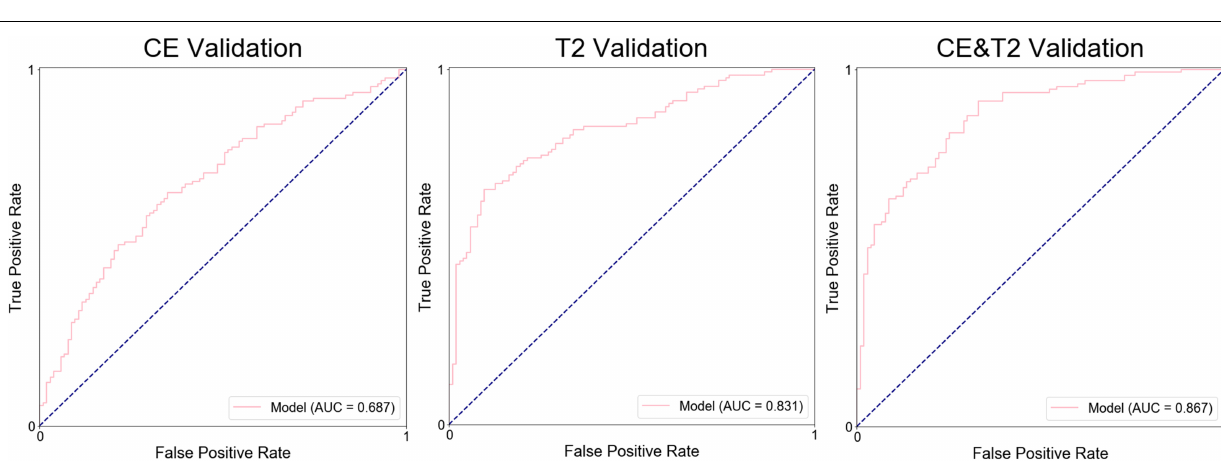
FIGURE 4 | Receiver operating characteristic curves for the groups of models during validation.